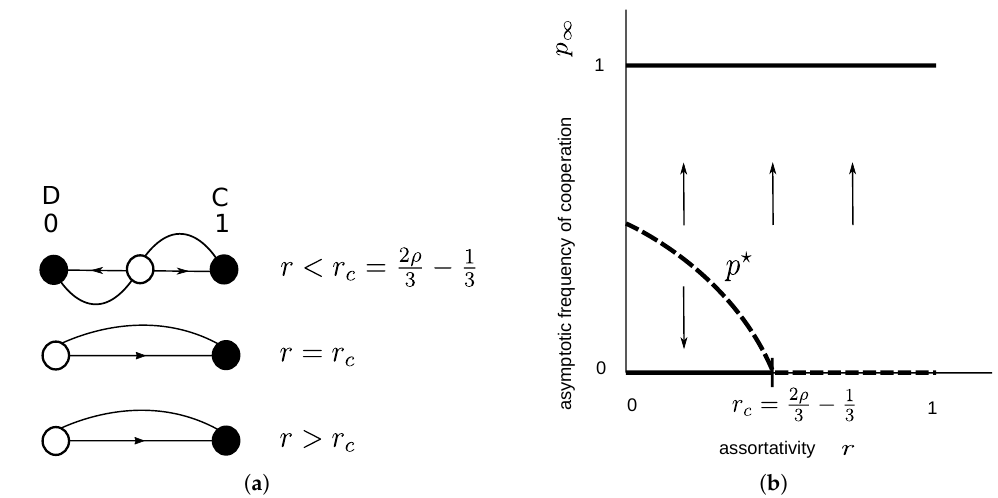
Figure 3. Phase line diagrams and the bifurcation diagram for the sculling game with assortative interactions. ( a ) In the phase line diagrams closed circles represent stable equilibrium points, open circles represent unstable equilibrium points, and the curved line connecting equilibrium points indicates the graph of the function on the right-hand side of the r -replicator equation. ( b ) In the bifurcation diagram solid lines represent stable equilibrium points, dashed lines represent unstable equilibrium points, and arrows indicate the direction of evolutionary